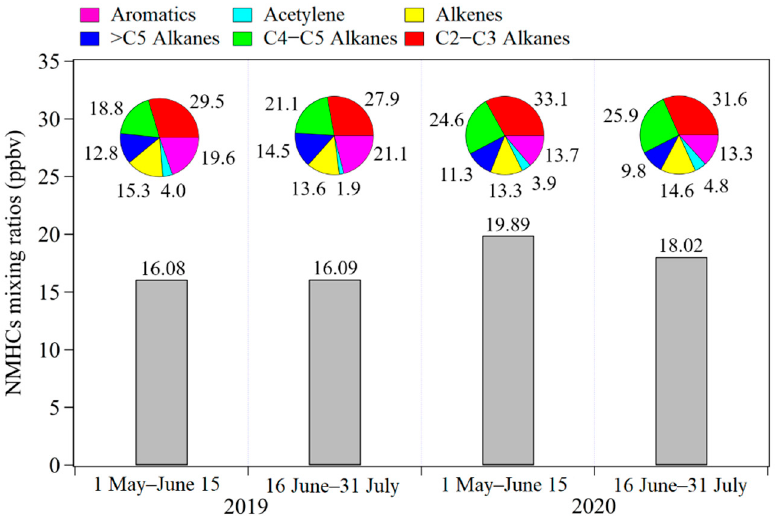
Figure 5. Comparison of average mixing ratios for non-methane hydrocarbons (NMHCs) during 1